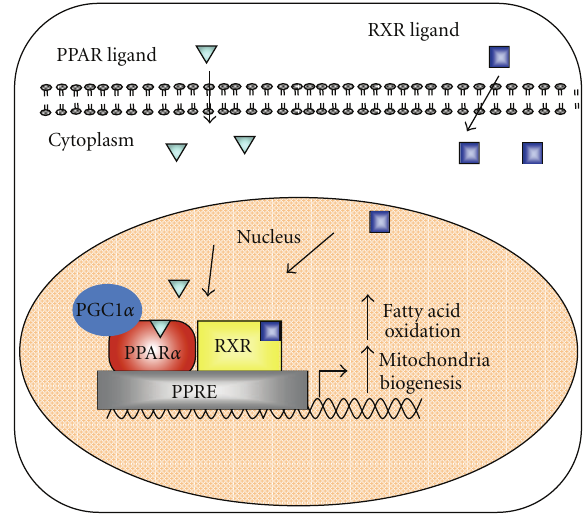
Figure 1: Regulation of gene expression by peroxisome proliferator-activated receptors. The nuclear hormone receptor PPAR α induces transcription through formation of a heterodimer with the retinoic X receptor and binding to peroxisome proliferator response elements (most are direct repeats with one intervening nucleotide) in the promoter of genes involved in fatty acid oxidation. PGC1 α is an important PPAR α coactivator in tissues that undergo extensive oxidative metabolism and induce mitochondrial